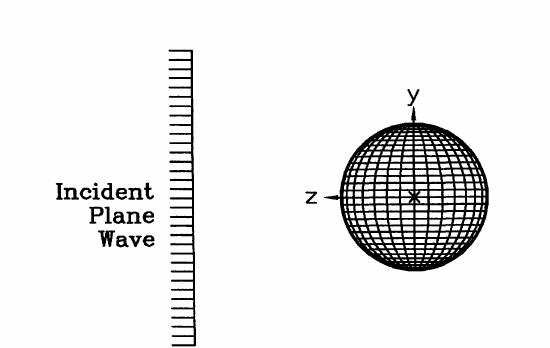
FIGURE 3 Spherical shell subjected to plane step wave problem